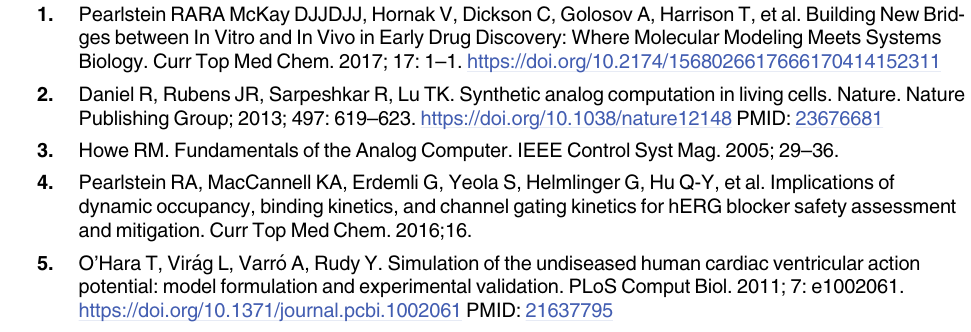
S6 Fig. (a) Plot of Btotal( τ ) (gray), c( τ ) at a fixed L0 = 1 nM and Λ = 3.85 hr (ki = k − i = 1x10-4 s-1), in which kon was sampled between 1x104 M-1 s-1 to 1x109 M-1 s-1 (solid lines color- coded from blue to red according to increasing kon), and Bfree( τ ) (dotted lines color coded the same as c( τ )). (b) Same as (a), except Λ = 2.3 min (ki = k − i = 1x10-2 s-1). (c) Same as (a), except Λ = 13.9 s (ki = k − i = 1x10-1 s-1). (d) Same as (a), except Λ = 1.39 s (ki = k − i = 1x100 s- 1). (e) Same as (a), except Λ = 139 ms (ki = k − i = 1x101 s-1). (TIF) S7 Fig. Plot of Btotal( τ ) (gray), c( τ ) at a fixed Kd = 1 nM, Λ = 2.3 min (ki = k − i = 1x10-2 s-1), koff = 1x10-5 s-1, and kon = 1x104 M-1 s-1, in which L0 was sampled between 1 nM and 500 nM (solid lines), and Bfree( τ ) (dotted lines color coded the same as c( τ )). kon < k compensated at sufficiently high L0, which in this case, qSSO at L0 = 500 nM.